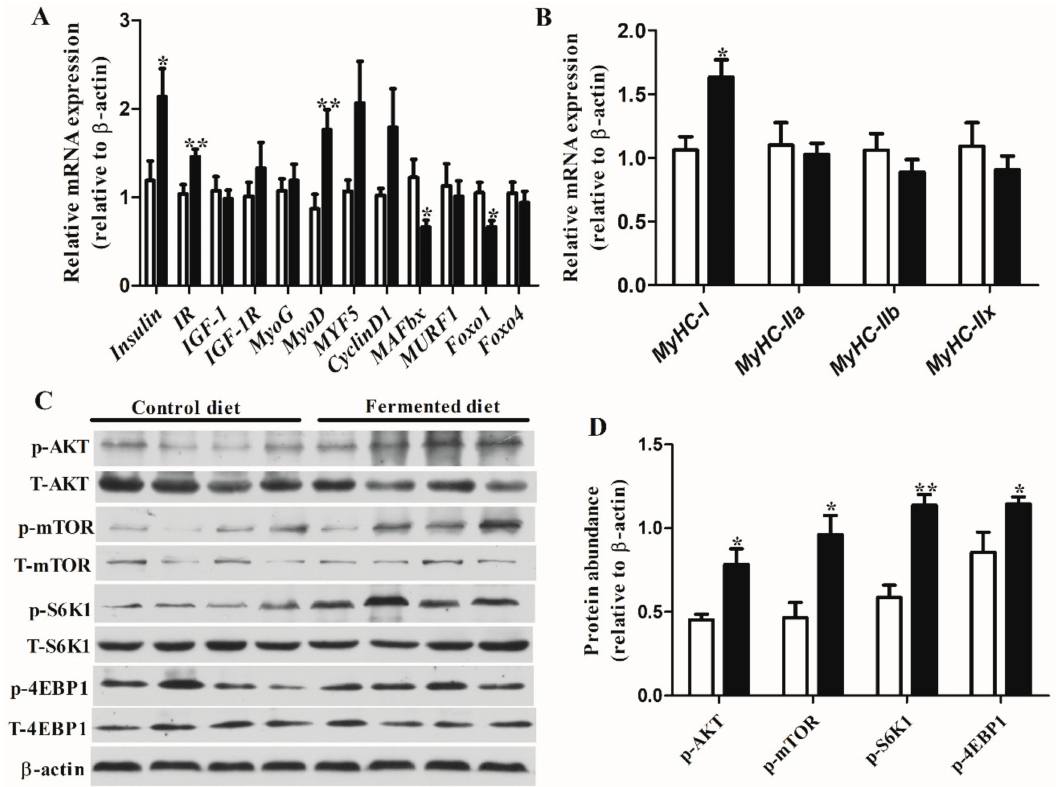
Figure 1. Diets e ff ect on indices related to protein synthesis of finishing pigs. Relative abundance transcripts of genes ( A ) Insulin, IR , IGF-1 , IGF-1R , MyoD , MyoG , MYF5 and CyclinD1, MAFbx , MURF1 , FoxO1 and FoxO4 in longissimus thoracis of finishing pigs. Relative abundance transcripts of genes ( B ) MyHC-I, MyHC-IIa , MyHC-IIb and MyHC-IIx in longissimus thoracis of finishing pigs. ( C ) Western blots illustrating the total and phosphorylation level of AKT, mTOR, S6K1 and 4EBP1 in longissimus thoracis. Equal protein loading was confirmed by analysis of β -actin in the protein extracts. ( D ) The ratios of p-AKT, p-mTOR, p-S6K1 and p-4EBP1 to β -actin. Data are means ± SEM. * p < 0.05, ** p < 0.01. IR , insulin receptor; IGF-1 , insulin like growth factor 1; IGF-1R , insulin-like growth factor 1 receptor; FoxO1 , forkhead Box O1; FoxO4 , forkhead Box O4; MyoD , myoblast determination protein; MyoG , myogenin; MYF5 , myogenic factor 5; MAFbx , muscle atrophy F-box; MURF1 , Ring finger 1; MyHC-I , myosin heavy chain (MyHC)-I; MyHC-IIa , myosin heavy chain (MyHC)-IIa; MyHC-IIb , myosin heavy chain (MyHC)-IIb; MyHC-IIx, myosin heavy chain (MyHC)-IIx; mTOR, mammalian target of rapamycin; 4EBP1, initiation factor 4E-binding protein 1; S6K1, S6 kinase